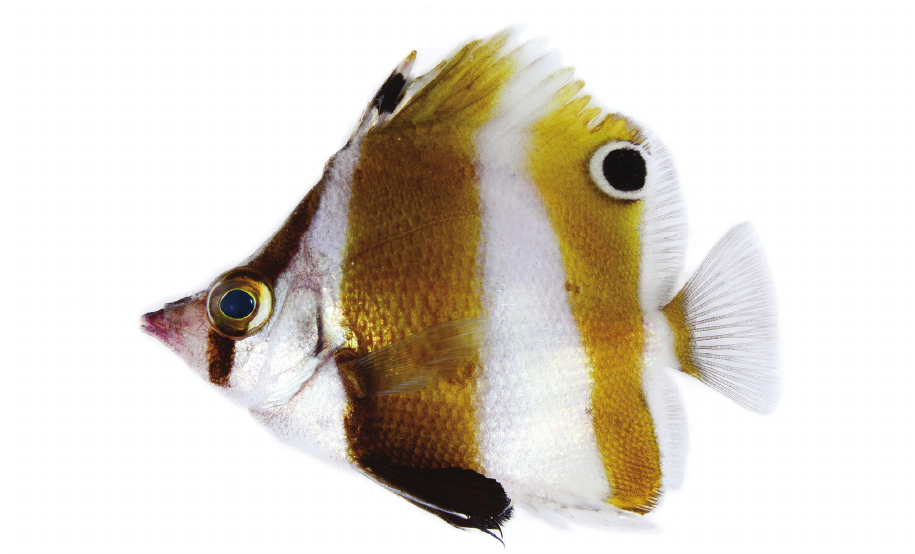
Figure 1. Roa rumsfeldi sp. n., holotype shortly after death, 77.53 mm SL, PNM 15198 (photo LA Rocha). Color in alcohol. As described above in color in life, but with lighter brown